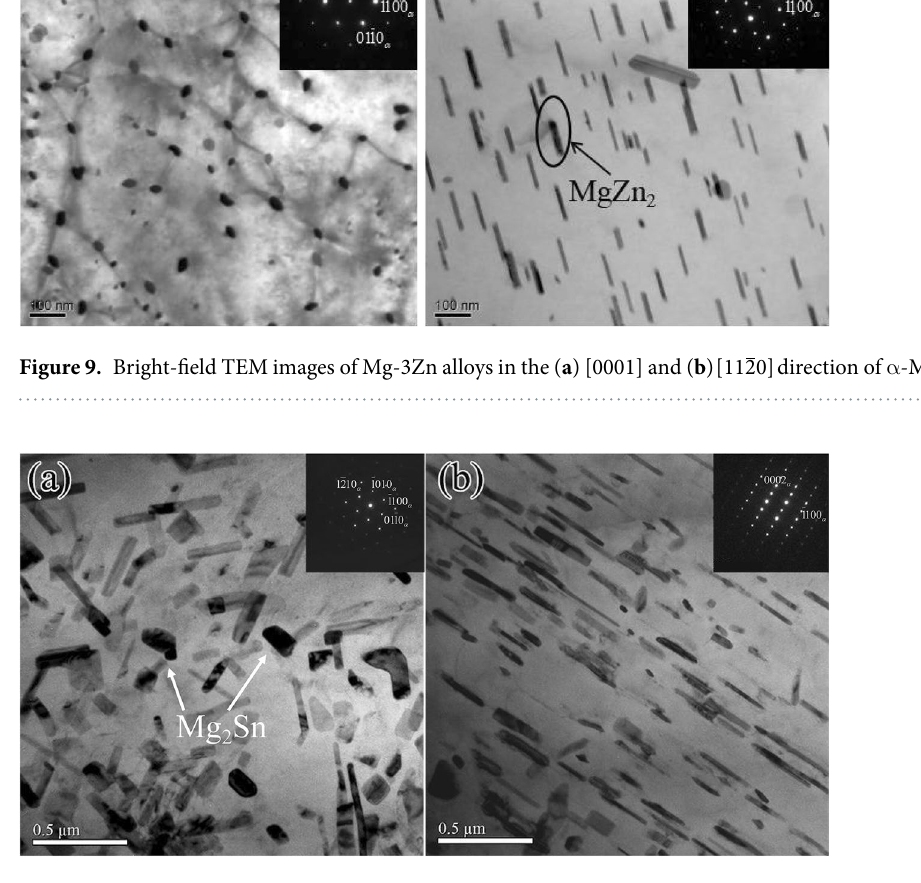
Shielding effectiveness at 1200 MHz (dB) Alloys